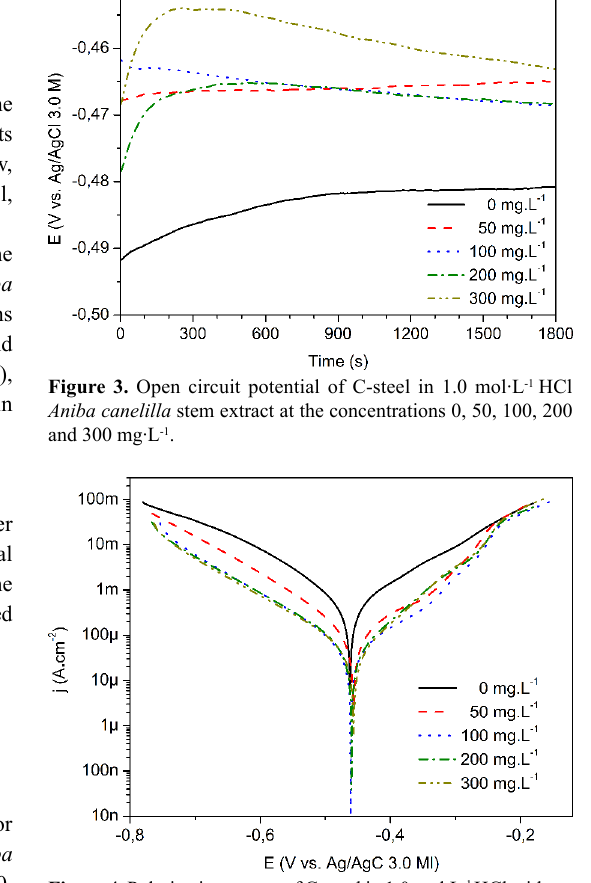
Figure 4. Polarization curves of C-steel in 1.0 mol∙L -1 HCl without and with ethanolic Aniba canelilla extract at 0, 50, 100, 200 and 300 mg·L -1 at 25.0